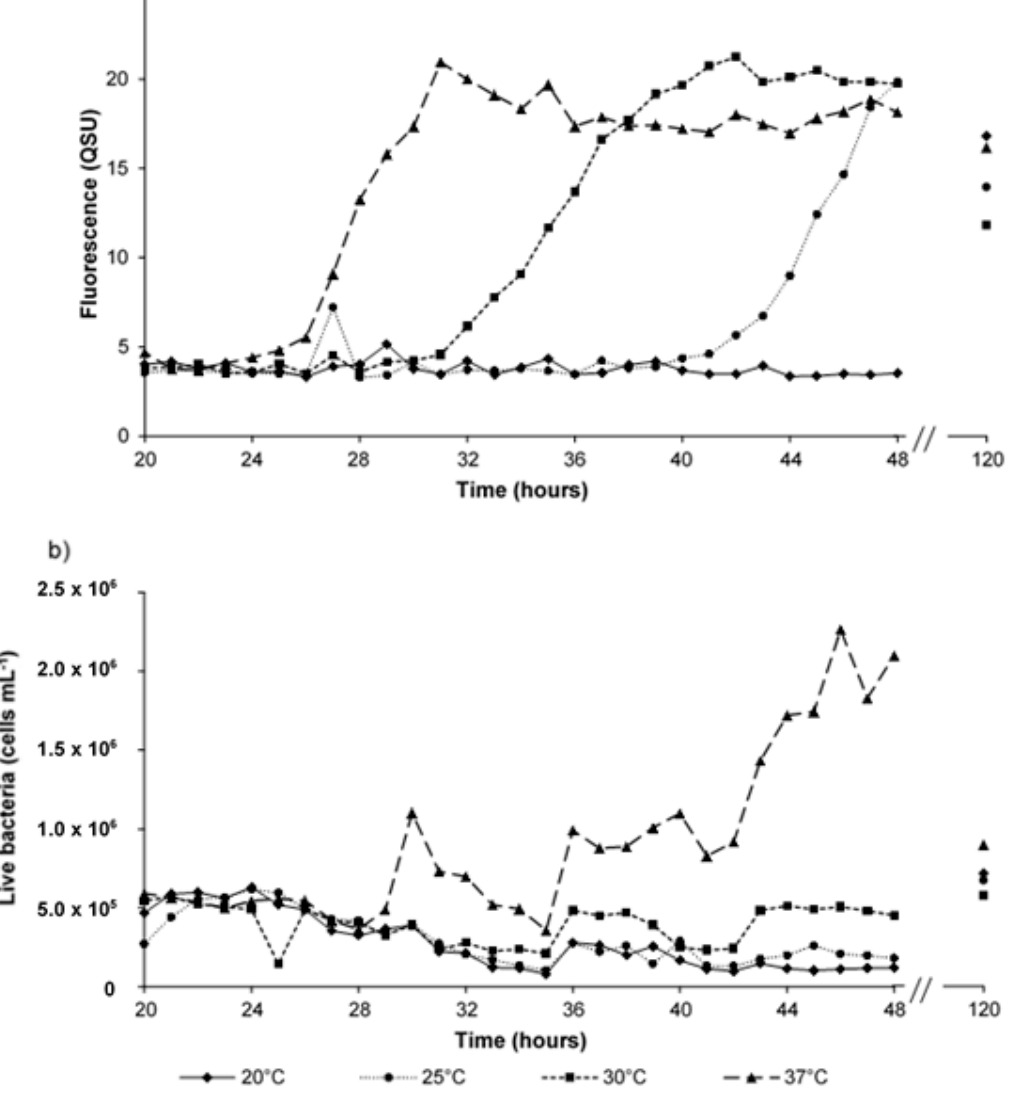
Figure 5. Fluorescence and bacterial enumeration data for synthetic water samples incubated at a range of temperatures over a five-day experimental period, showing; ( a ) Peak T fluorescence, QSU (1 QSU = 1 µ g L − 1 quinine sulphate); and ( b ) the number of living bacteria (cells mL − 1 ). Data shown is from 20 to 48-h plus a single time point at day five (120 h).